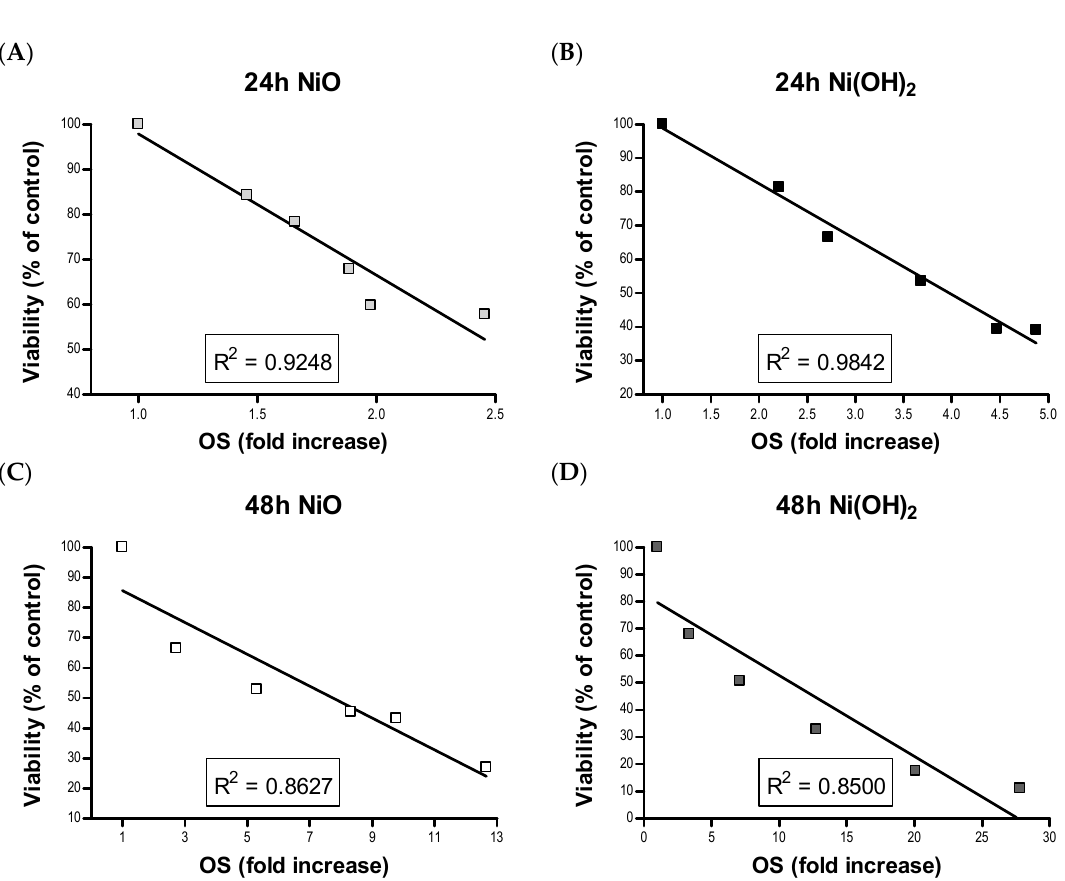
Figure 11. Linear correlation between viability and oxidative stress (OS) rankings for ( A ) 24 h NiO, ( B ) 24 h Ni(OH) 2 , ( C ) 48 h NiO, and ( D ) 48 h Ni(OH) 2 .